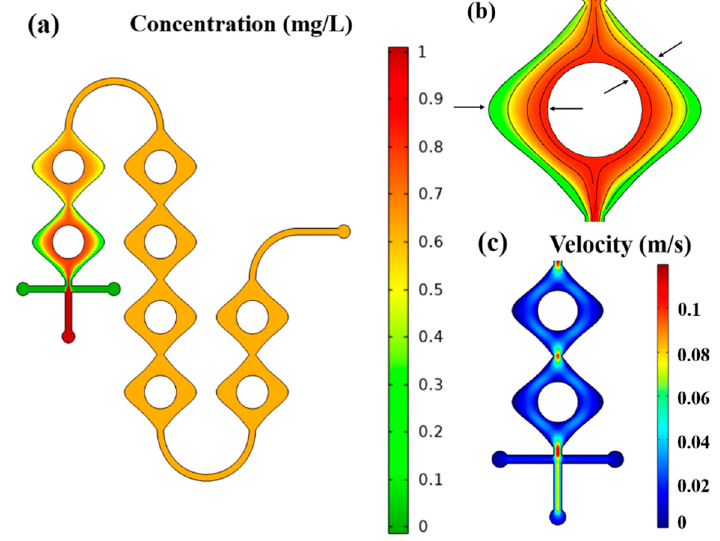
Figure 3. Simulation of flow for mixing and chromogenic reaction; ( a ) concentration distribution in the mixer; ( b ) distortion of concentration lamina; ( c ) flow rate distribution in the mixer.